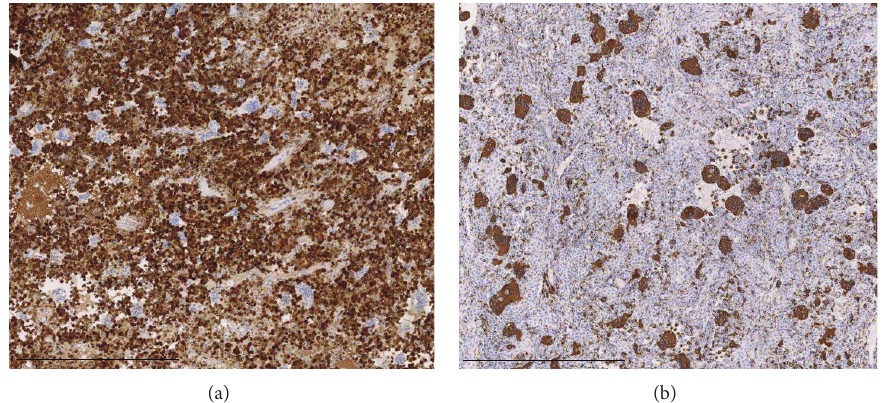
Figure 4: Immunohistochemical staining for S-100 protein (a) and for CD68 (b). Both scale bars indicate 500 𝜇 m.